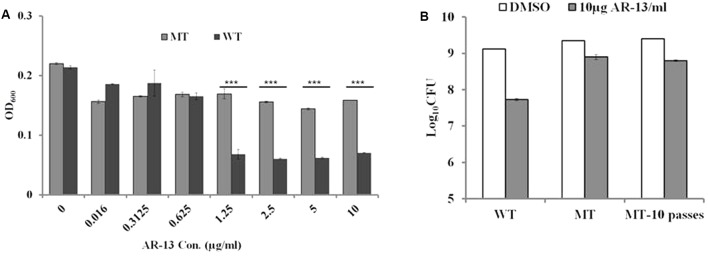
Stability of AR-13 resistance. (A) Growth curve of LVS (WT) and the LVS AR-13 resistant mutant (MT) in the presence of various concentrations of AR-13 in mTSB. WT or MT were grown in twofold serial dilutions of AR-13 with a starting concentration of 10 μg/ml. Optical densities at 600nm (OD600) were measured by a plate reader at 18 h after inoculation. (B) AR-13 resistance is stable. Approximately 1.5 × 109 CFU of WT or MT after 10 overnight passes in AR-13-free mTSB (MT-10 passes) were incubated in 1 ml PBS containing 10 μg AR-13. Viable bacteria were evaluated at 3 h post-treatment by serial dilution and plating. Data were representative of 2–4 independent experiments each performed in triplicate; ∗∗∗p < 0.001; NS, not significant.